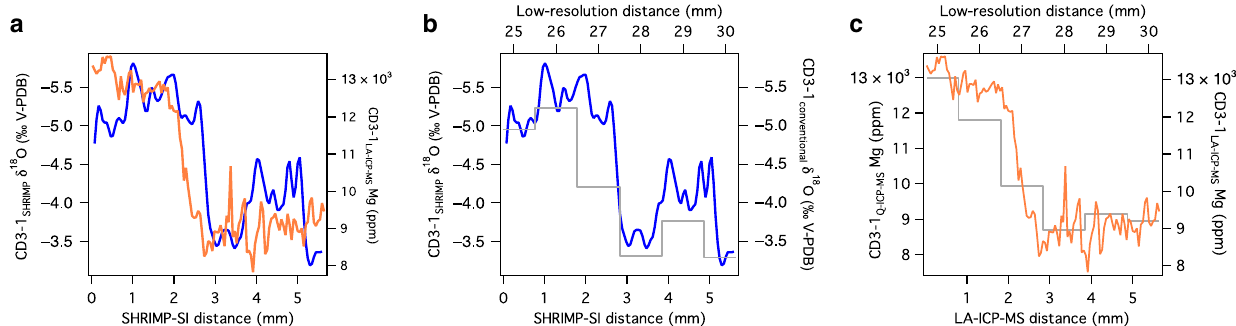
Fig. 4 High-resolution data from CD3-1 for Termination II. a SHRIMP-SI ion-microprobe δ 18 O (blue) and laser-ablation (LA) ICP-MS Mg (orange) series plotted on a common distance scale. The LA-ICP-MS measurements were made on the exact spot positions of the SHRIMP-SI analyses (see Methods). SHRIMP-SI data are shown as a three-point Gaussian smooth of the raw series (see Supplementary Fig. 4). b Comparison between the high-resolution SHRIMP-SI δ 18 O (blue; measured by ion-microprobe) and the low-resolution δ 18 O data (grey cityscape line plot; measured conventionally). c Comparison between the high-resolution LA-ICP-MS Mg (orange) and low-resolution Mg (grey cityscape line plot; measured by solution